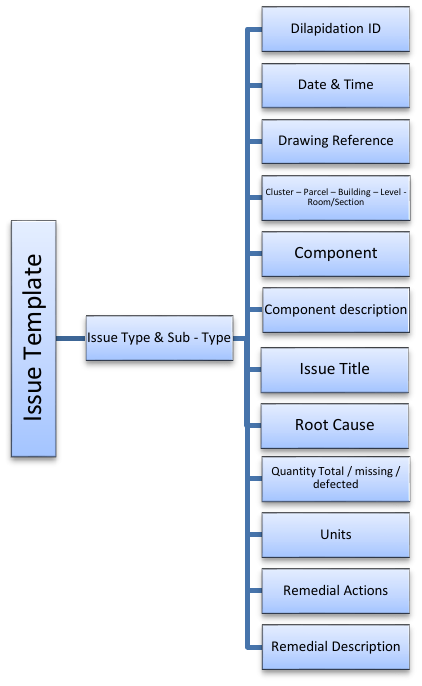
Figure 7: Hierarchy of Issue Template in BIM 360 Build